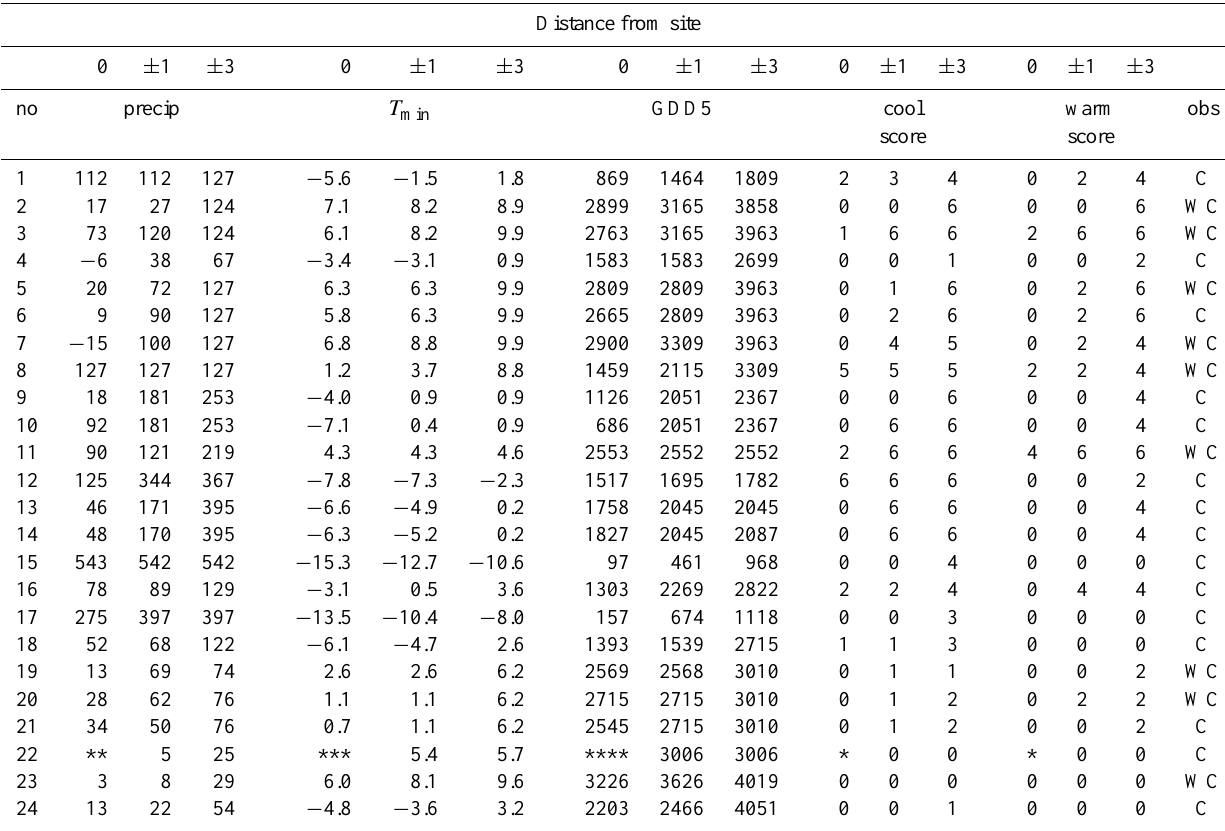
Table 7. Same as Table 5 for the ECHAM5 T31 coupled simulation (T31EH5).